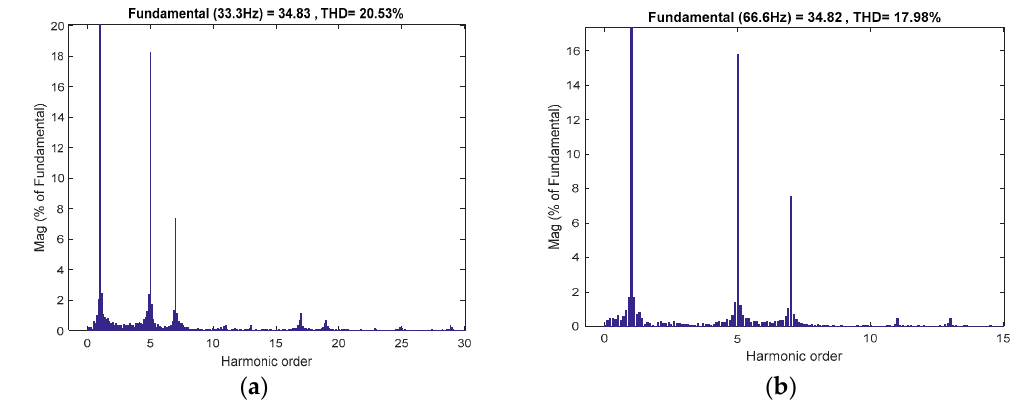
Figure 14. Total harmonic distortions (THDs) of the phase A current without adopting voltage compensation and resonant controller in x-y subspace, (a) speed is maintained at 500 rpm and (b) speed is maintained at 1000 rpm.